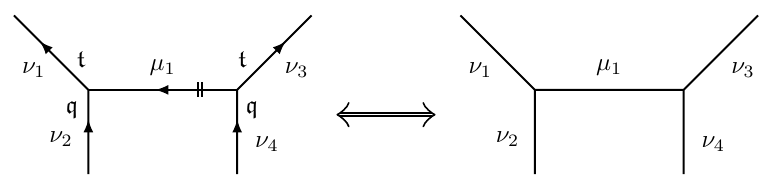
Figure 2 . Convention for assignment of the arrows and the Ω -deformation parameters throughout the